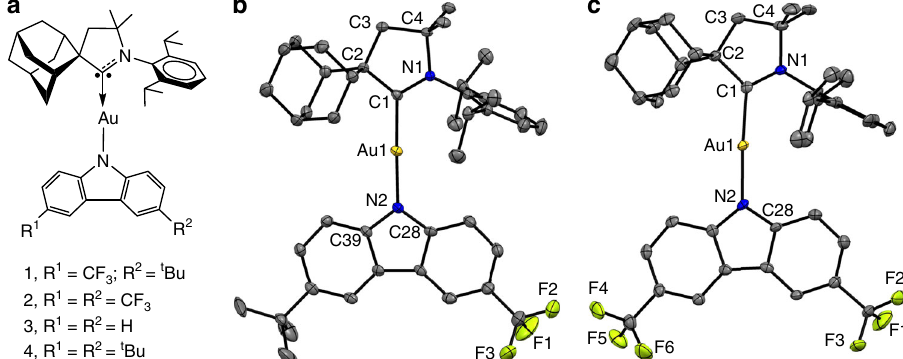
Fig. 1 Molecular and crystal structures. a Molecular structures of carbene – metal – amides 1 , 2 , 3 and 4 . Single-crystal X-ray structures of 1 ( b ) and 2 ( c ). Ellipsoids are shown at 50%